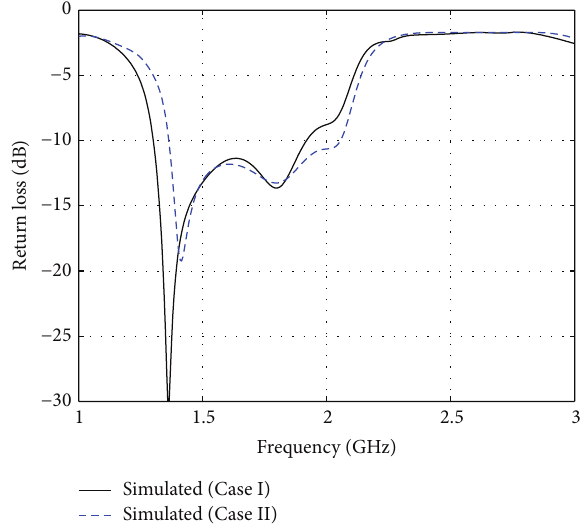
Figure 6: DRA return loss for both cases (Case I and Case II, as mentioned in Table 1), with 𝑎 = 32 mm, 𝑏 = 29.6 mm, 𝑑 = = 30 mm, 𝑊 = 5.3 mm, 𝐿 = 22 mm, 𝑊 = 1.5 mm, 48.85 mm, 𝐿 1 1 2 2 = and 𝑀 1 = 20 mm and 𝑀 2 = 45 mm, 𝑇 = 2.95 mm, 𝑑 sma = 1.575 mm, 𝑃 = 5 mm, and 𝐿 = 𝑊 = 130 mm. 44.26 mm, 𝑠 𝑑 th